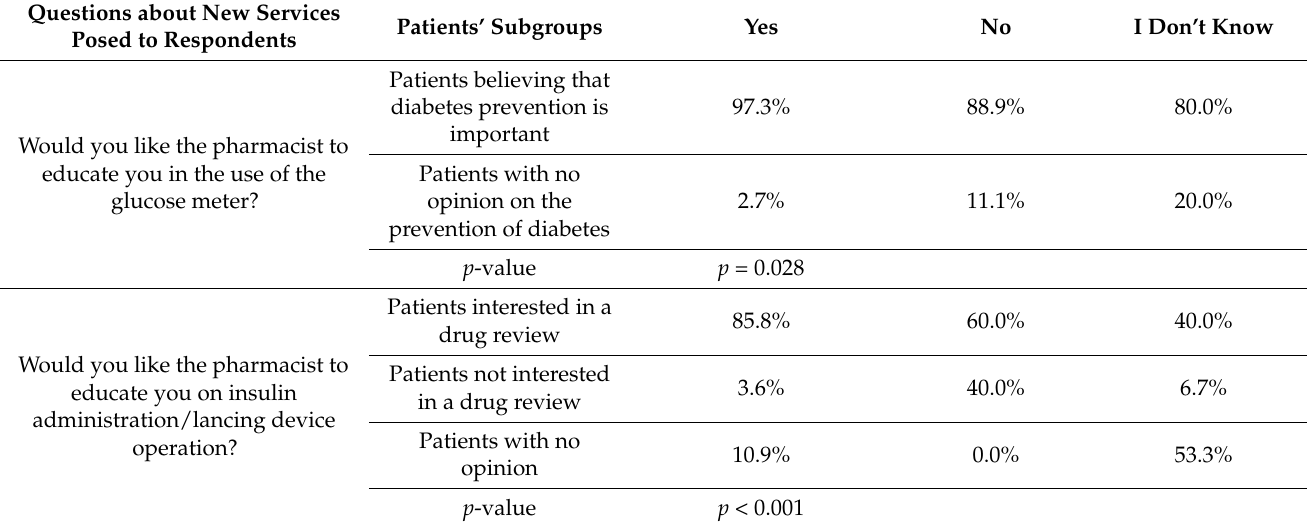
Table 3. Patients’ interest in procedural instruction services— only statistically significant differ- ences between subgroups.